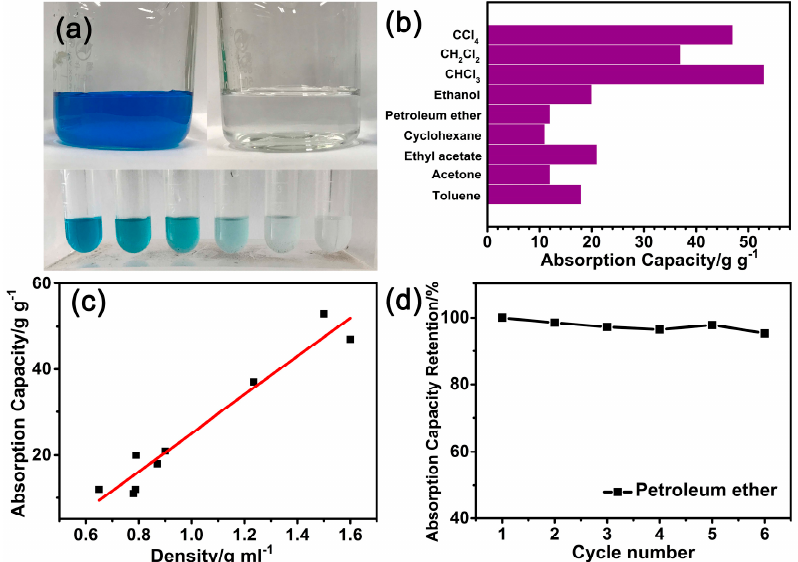
Figure 6. ( a ) Images showing absorption process of MB by N-CA within 2 h; ( b ) absorption capacities of N-CA for some organic solvents; ( c ) absorption capacities of the N-CA measured for investigated organic solvents in terms of the solvent densities; and ( d ) recyclability of the N-CA for absorption of petroleum ether after six heating